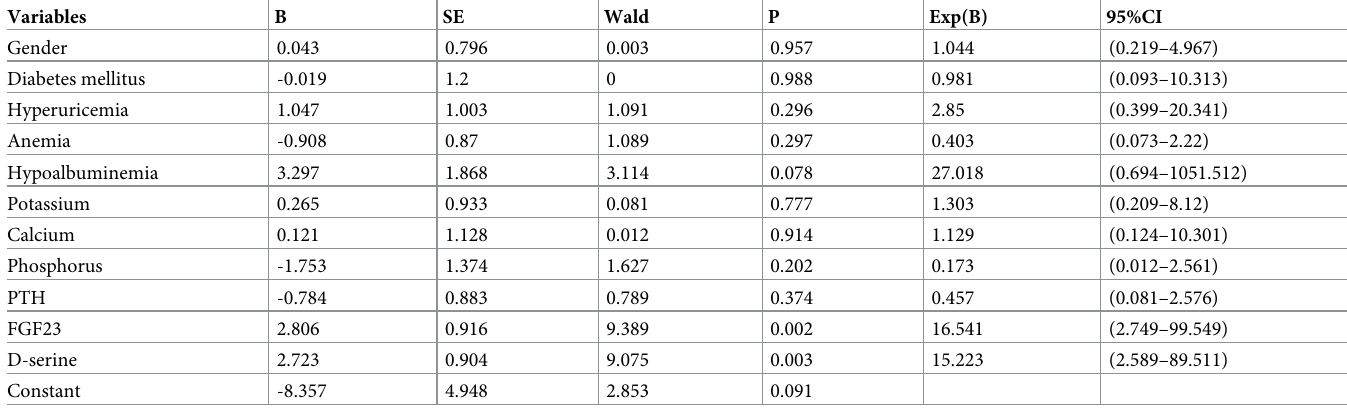
Table 2. Factors influencing hearing impairment in MHD